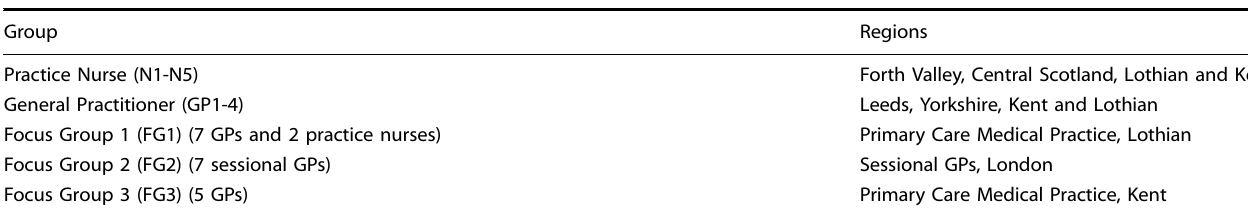
Table 1. Sources of